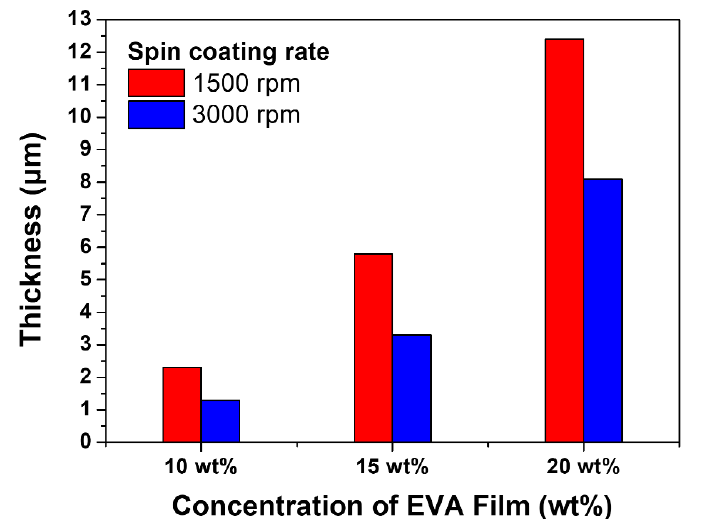
Figure 3. The thickness of the thin film at spin-coating speed of 1500 rpm (red line) and 3000 rpm (blue line) at 10, 15, and 20 wt.% EVA concentration.